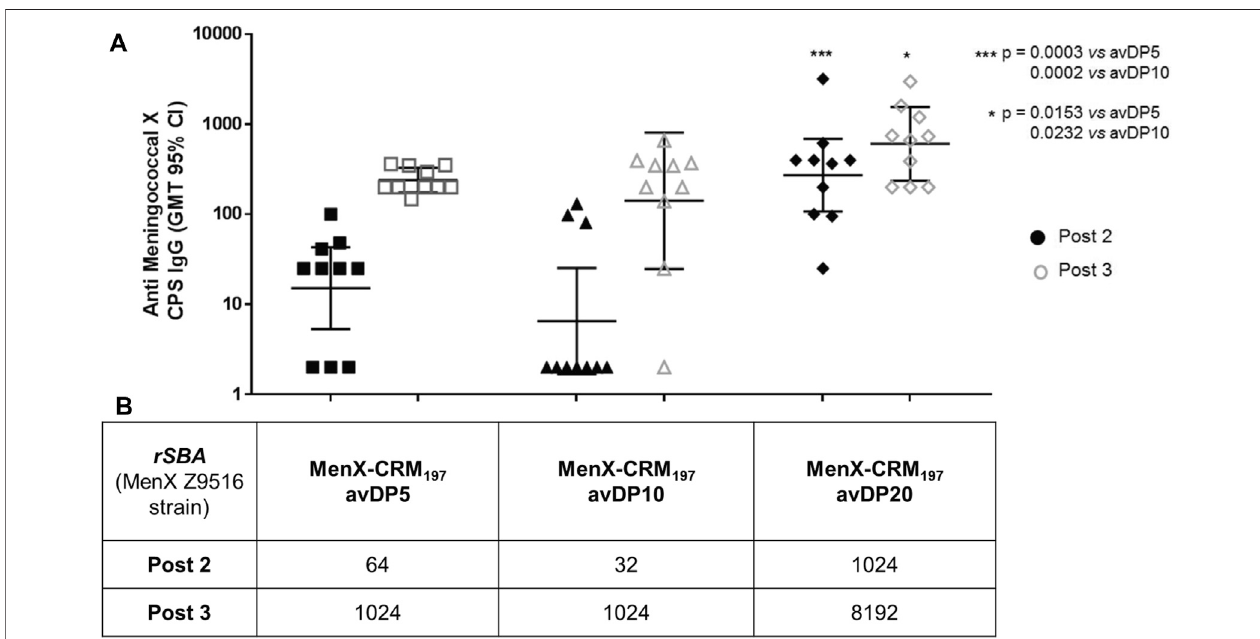
FIGURE 6 | Immunogenicity of different length MenX OSs conjugated to CRM 197 . (A) ELISA geometric mean IgG titers and (B) SBA titers measured after the second and third doses arereported. Dataare obtained from immunization ofeight female BALB/c mice bysubcutaneous injection of glycoconjugates at a1 µg dose in saccharidecontentusing alumphosphate asanadjuvant.Mice received thevaccines atdays 1,14, and28.Mice werebled at days0,27, and42. Dotsrepresent single mice serum. Statistics was calculated with Mann – Whitney.